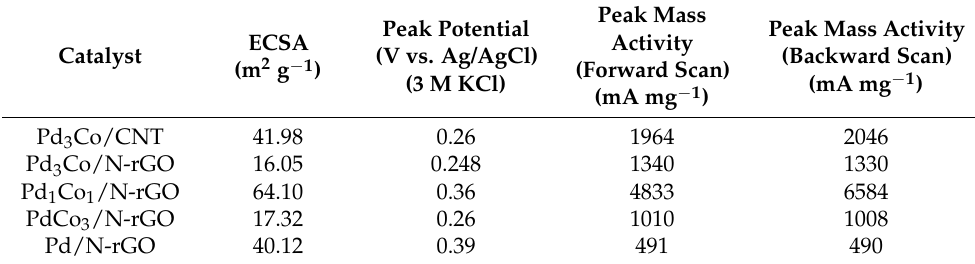
Figure 7. ( A ) Cyclic voltammetry (CV) for the catalysts in 0.5 M H 2 SO 4 and 0.5 M HCOOH solutions at a scan rate of 20 mv s –1 at room temperature ( B ) peak mass activity for the as-prepared catalysts in the CV scan. Table 2. Electrochemical performance of the as-prepared